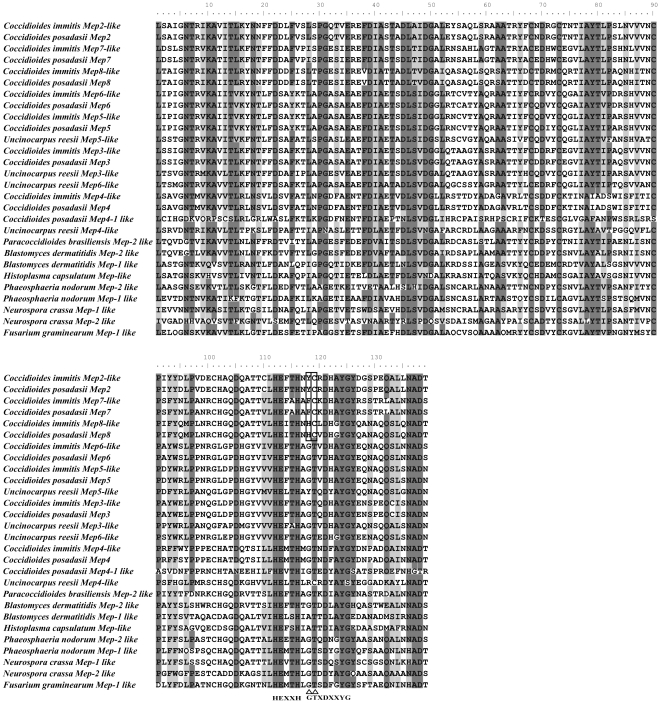
Protein alignment of 28 M35 genes.Areas shaded in black are conserved regions (100% similarity). Areas shaded in grey have a high degree of homology (more than 75% similarity), while those unshaded areas are highly variable regions between the proteases. Two positively selected residues identified in branch i are indicated.